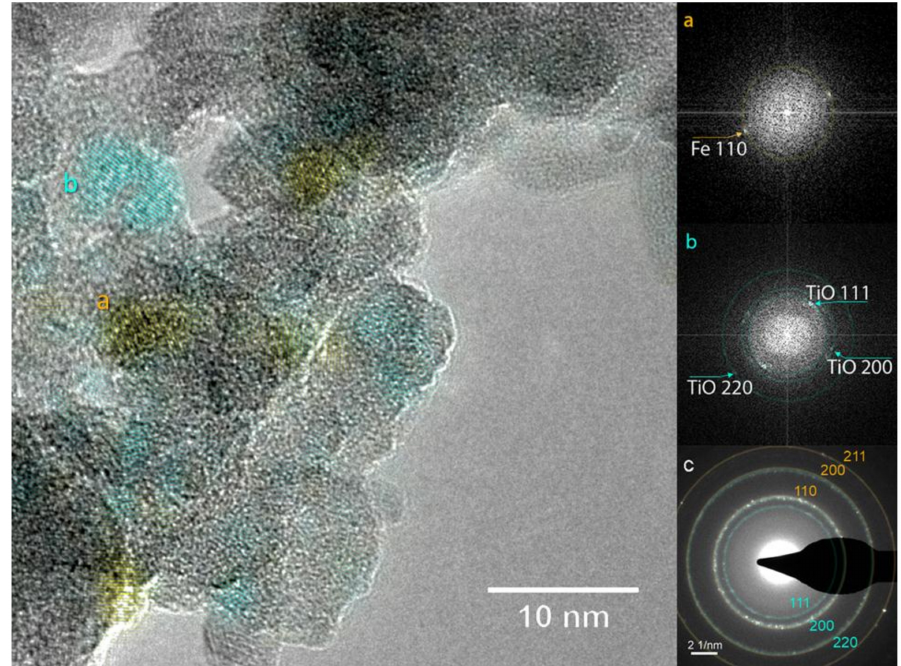
Figure 9. HR-TEM image of the as prepared Fe/TiO x NC (left) and FFTs performed on selected areas labeled with lowercase letters showing the presence of ( a ) Fe and ( b ) TiO 1- δ lattice planes; ( c ) SAD pattern: Fe and TiO 1- δ lattice planes are labeled in yellow and cyan, respectively (yellow and cyan rings serve as guides for the eye). In the HR-TEM image, the lattice planes of Fe and TiO 1- δ are highlighted using the same